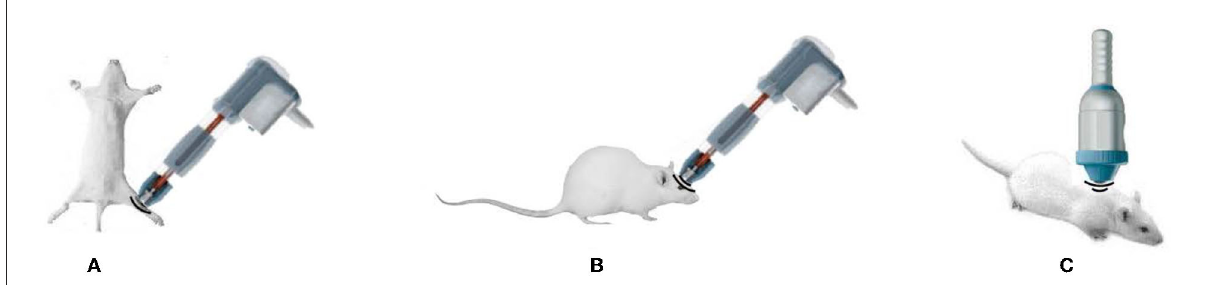
FIGURE2 Animal studies of the use of ESWT in sciatic nerve (A) , brain (B) , and spinal cord (C) .